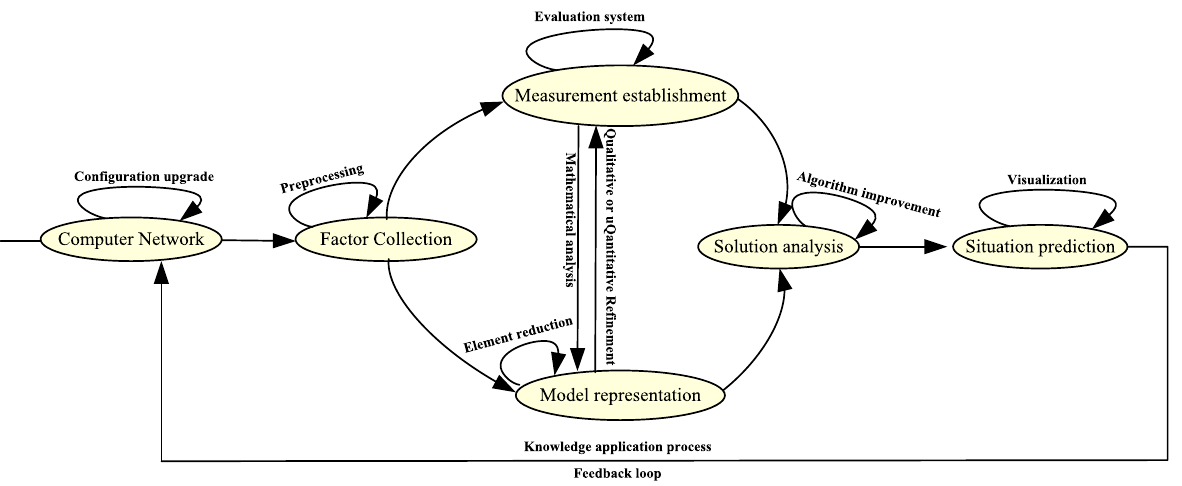
Fig. 3 Network security situational awareness operation